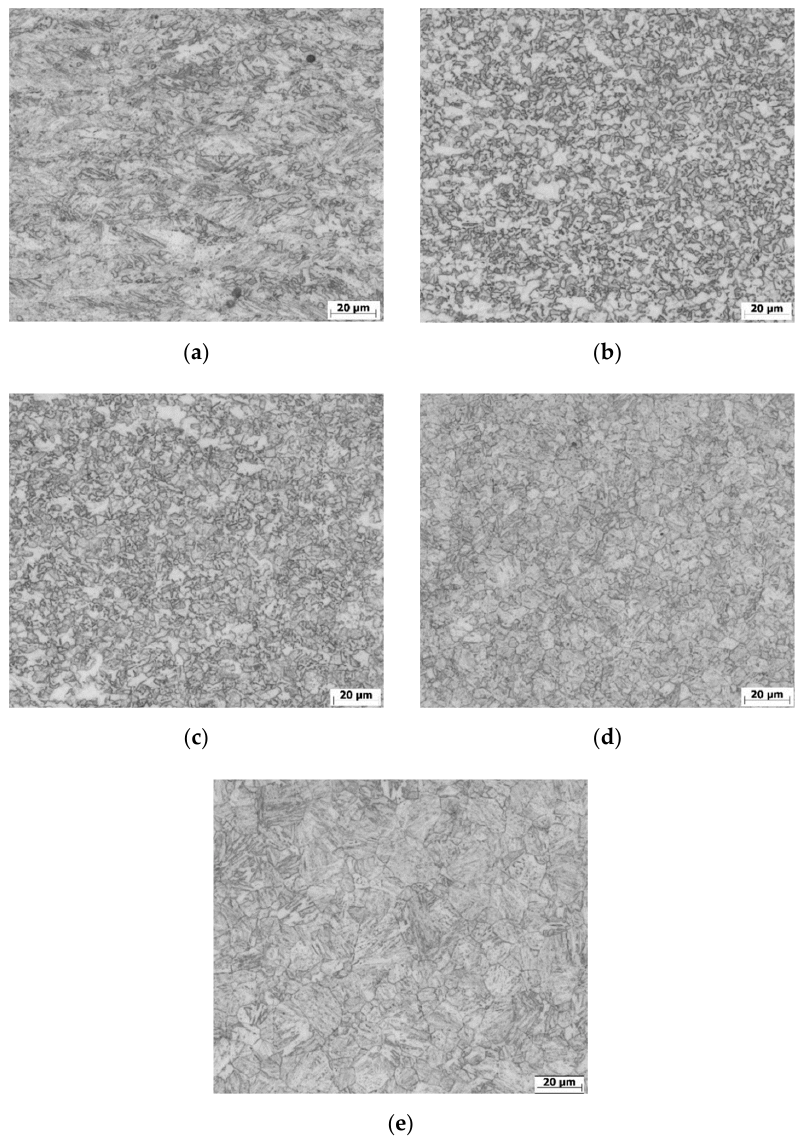
Figure 17. Microstructure of individual subzones from the center of the 7s sample to its edge: ( a ) BM—ICHAZ transition area; ( b ) ICHAZ; ( c ) ICHAZ—FGHAZ transition area; ( d ) FGHAZ; ( e ) FGHAZ—CGHAZ transition